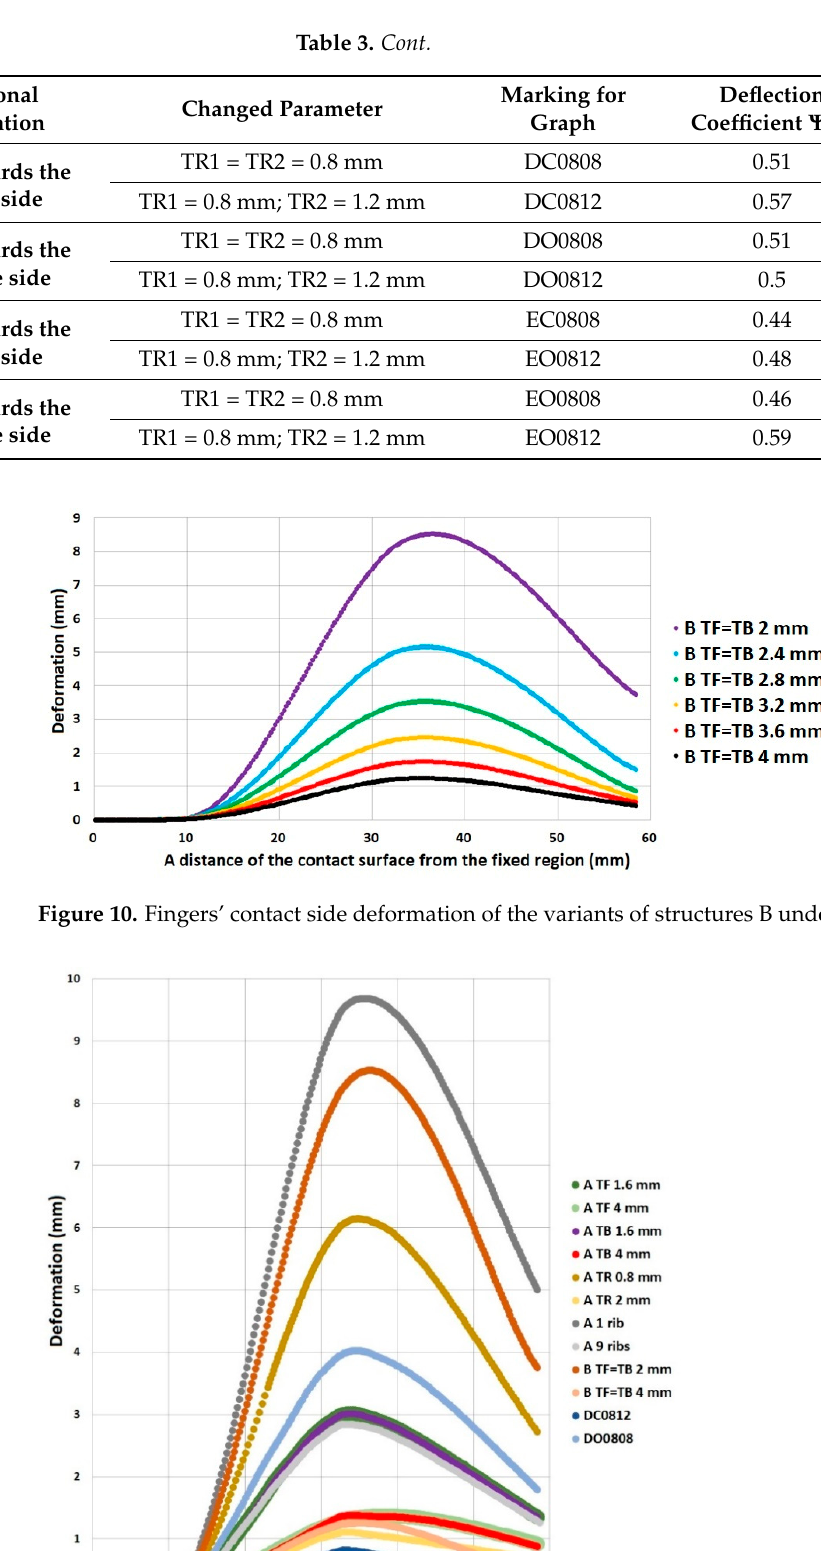
Figure 11. Comparison of all structures according to deformation under load 5 N.